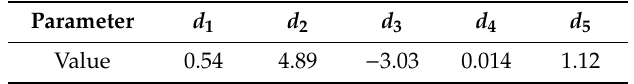
Table 1. Johnson–Cook (JC) damage model parameters for OFHC copper [20].